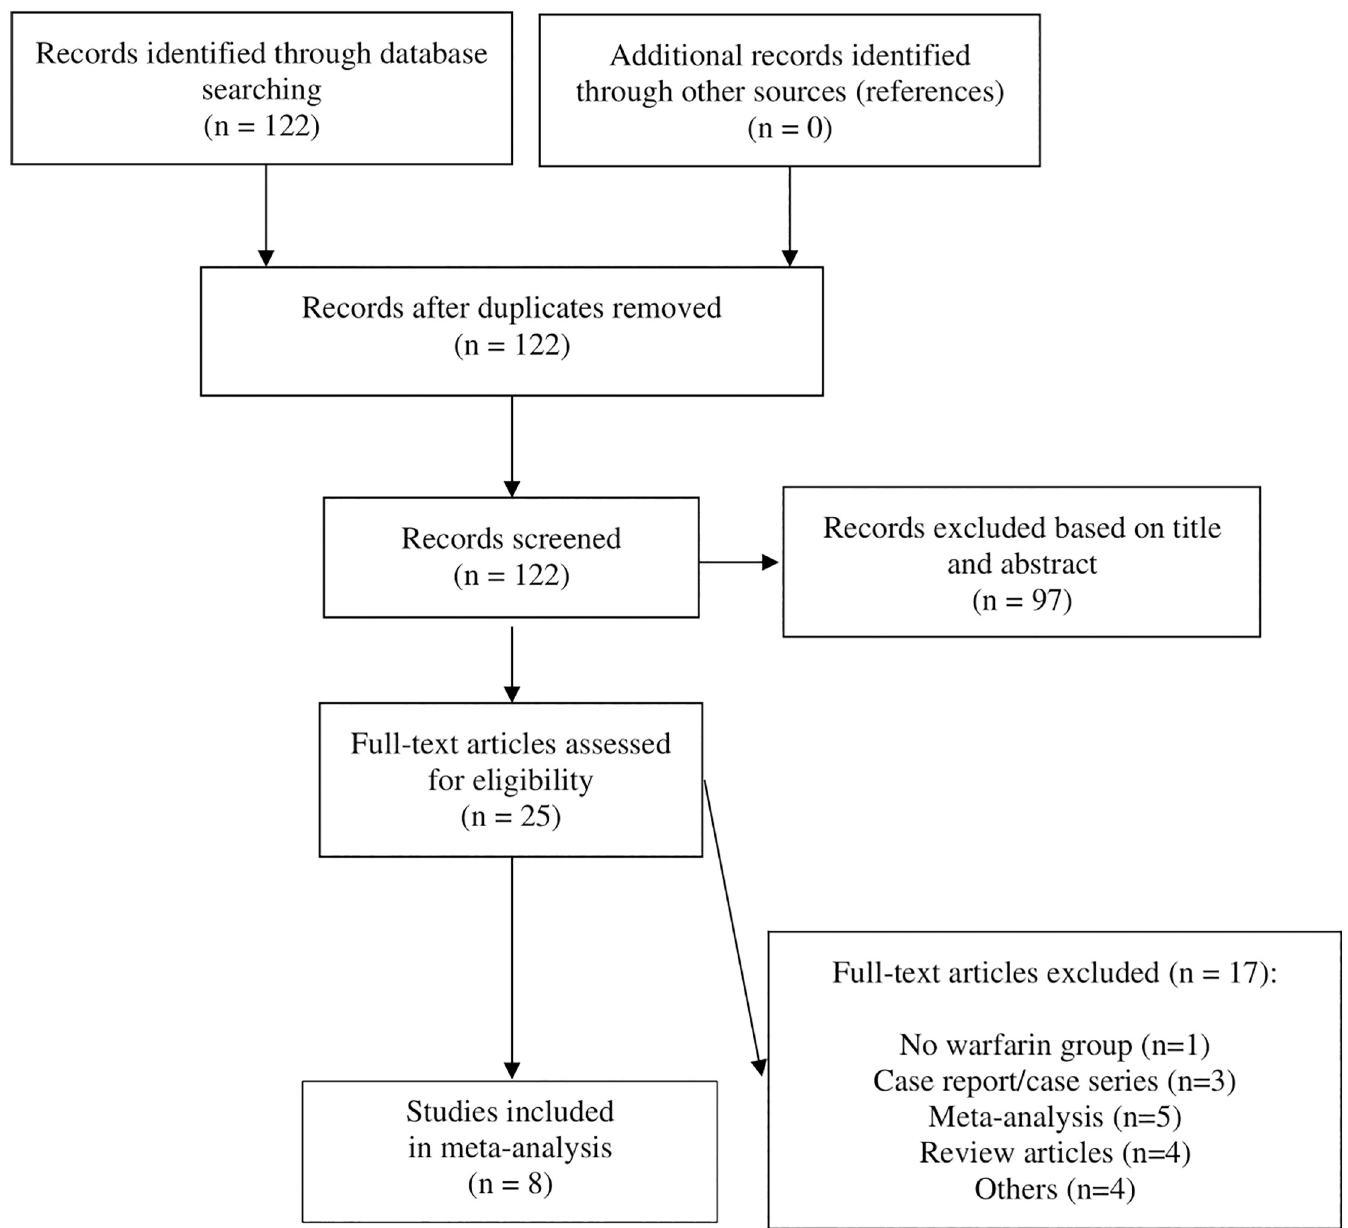
Fig 1. Flow diagram of DOACs versus VKA in patients with left ventricular thrombus literature search.